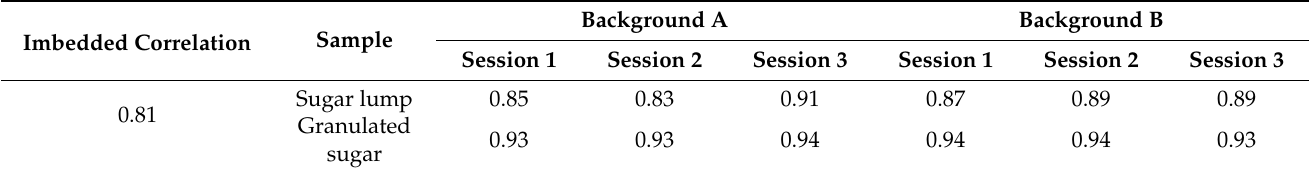
Table 4. K correlation indexes for the error matrix of NeoSpectra Scanner data. A indicate background acquired before each sample. B indicate background acquired before each session of